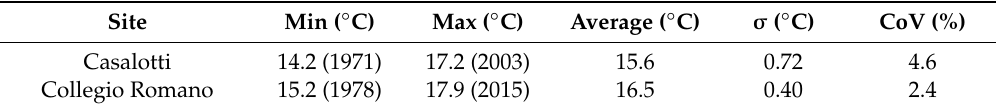
Table 3. Summary statistics of annual average temperature at Casalotti and Collegio Romano sites,